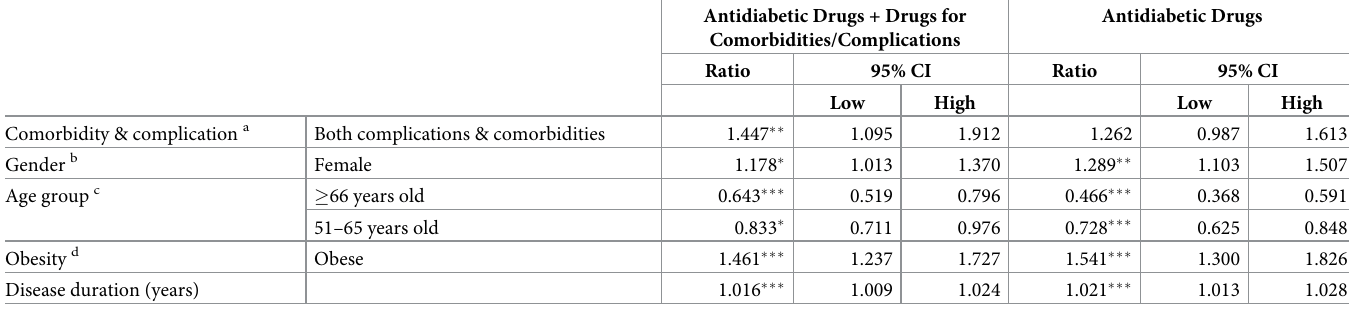
Table 3. Effect of patients’ demographics and clinical characteristics on mean drug cost.